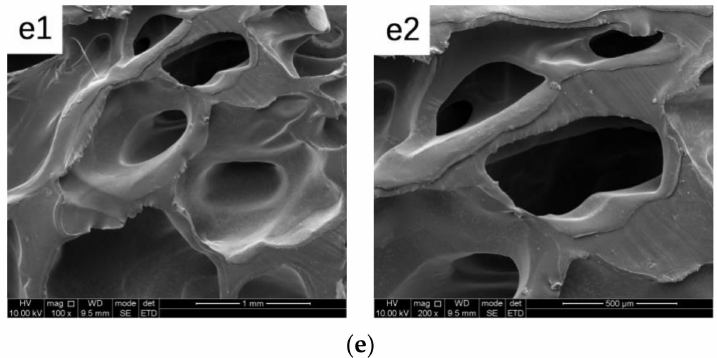
Figure 5. Scanning electron microscopy (SEM) images of ( a ) PTMG / PEG 100 / 0 (a1 100 × , a2 200 × ), ( b ) PTMG / PEG 75 / 25 (b1 100 × , b2 200 × ), ( c ) PTMG / PEG 50 / 50 ((c1) 100 × , (c2) 200 × ), ( d ) PTMG / PEG 25 / 75 ((d1) 100 × , (d2) 200 × ), ( e ) PTMG / PEG 0 / 100 ((e1) 100 × , (e2) 200 × ).